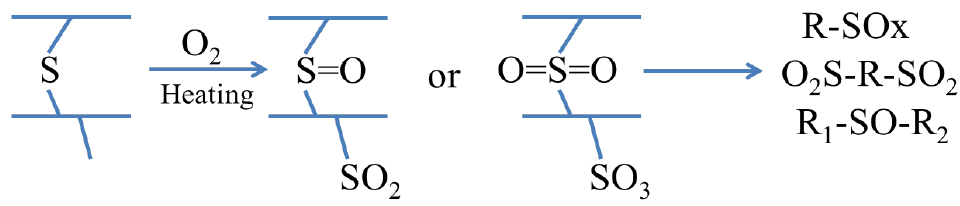
Figure 5. Possible mechanism of the partial oxidation and the pyrolysis reaction with limiting thermal cracking.